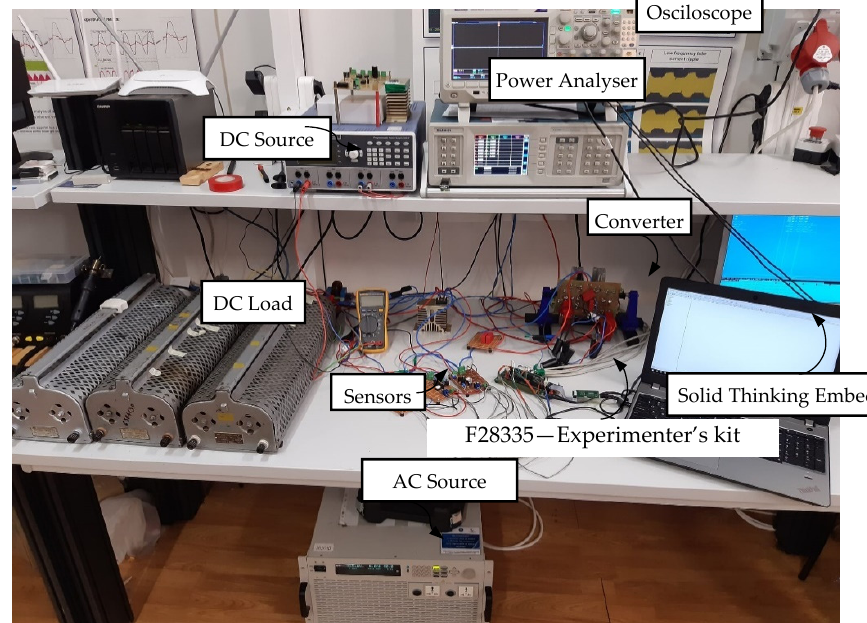
Figure 9. Laboratory test setup.